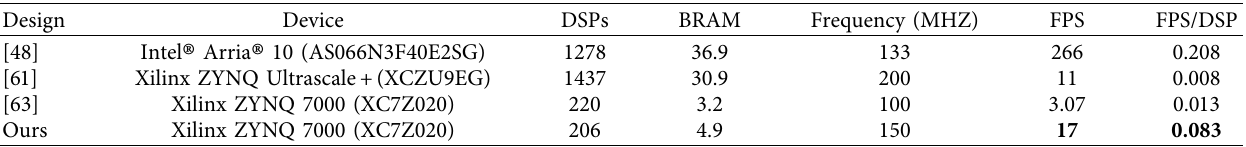
Table 8: Comparison with previous FPGA-based